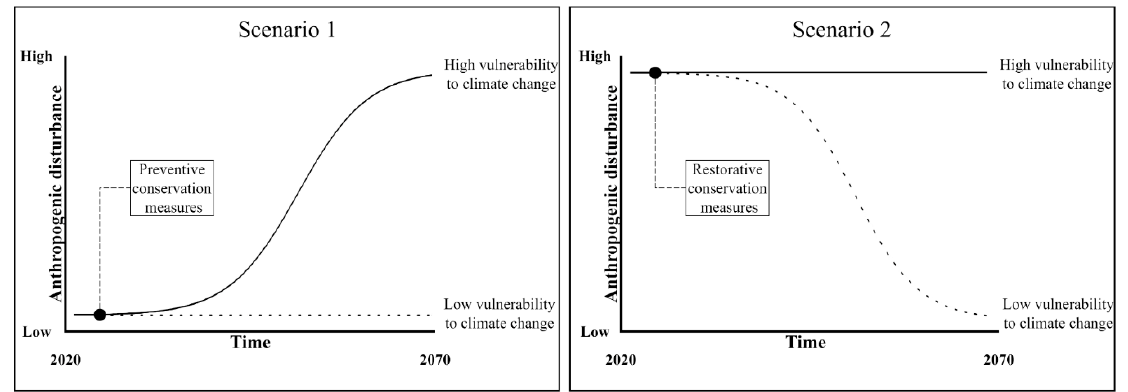
Figure 4. Two conceptual scenarios to describe when and what type of conservation measures are needed to increase the resilience of forest to changes in climatic conditions. Left : Scenario 1. Without conservation measures, anthropogenic disturbance of forest will increase over time, leading to a higher vulnerability to climate change in the future (displayed by the solid line). When preventive conservation measures are implemented, currently low levels of anthropogenic disturbance could be maintained, leading to enhanced forest functioning and a lower vulnerability of forest to climate change (displayed by the dashed line). Right : Scenario 2. Without conservation measures, anthropogenic disturbance of forest will remain high over time, leading to a higher vulnerability to climate change in the future (displayed by the solid line). When restorative conservation measures are implemented, currently high levels of anthropogenic disturbance could be reduced, leading to a lower vulnerability of forest to climate change (displayed by the dashed